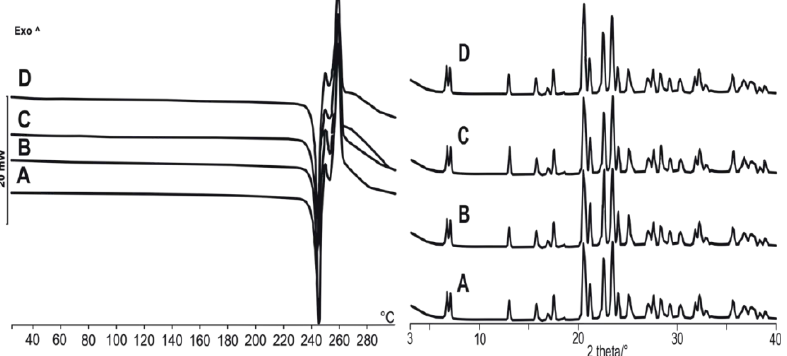
Figure 6. X-ray powder diffractometry (XRPD) and differential scanning calorimetry (DSC) results of the four products with proper mean particle size, aspect ratio, and roundness values.